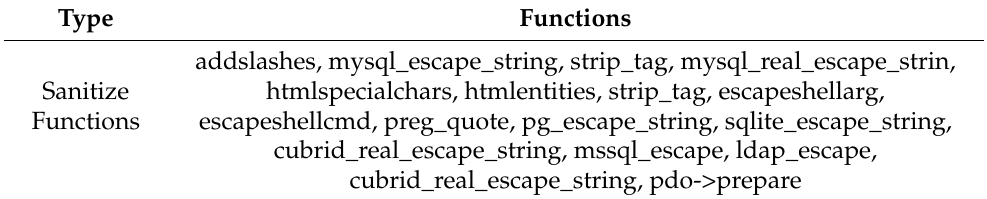
Table 2. Common PHP Sanitize